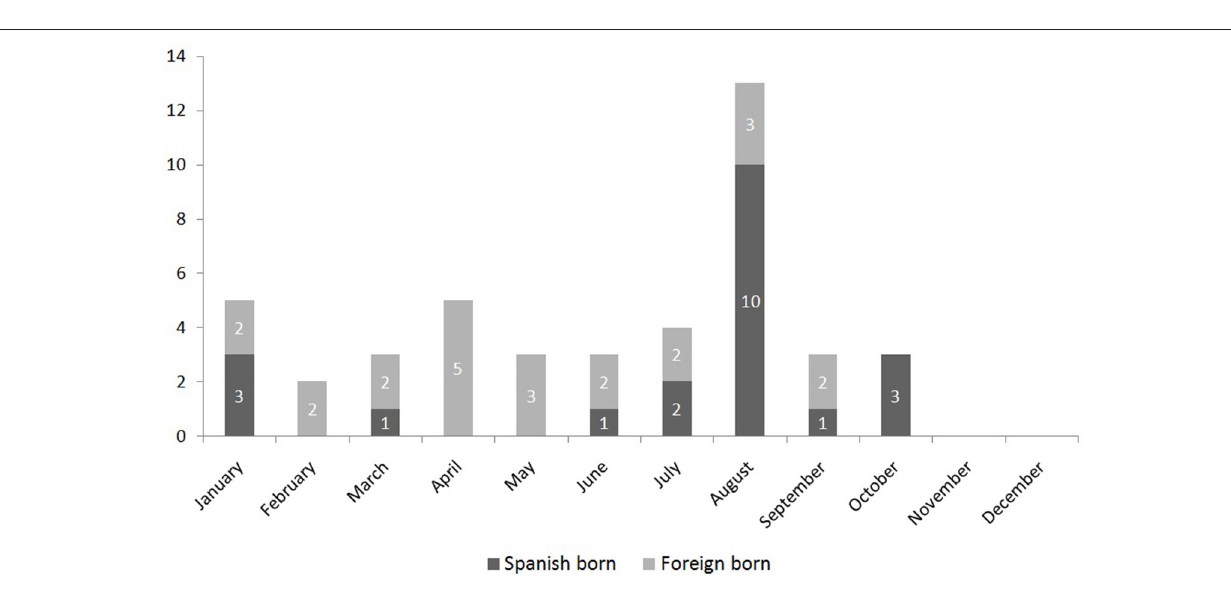
A total of 31 cases (70.5%) were arrived in Barcelona during the viremic period and 13 (30%) arrived during the incubation phase and became viremic in the city ( Figure 4 ). The proportion of viremic immigrants for 8–9 days in Barcelona was higher than for the Spanish born ( Table 1 ) (61% vs. 29%), p = 0.034. The median time, for Spanish born, elapsed between